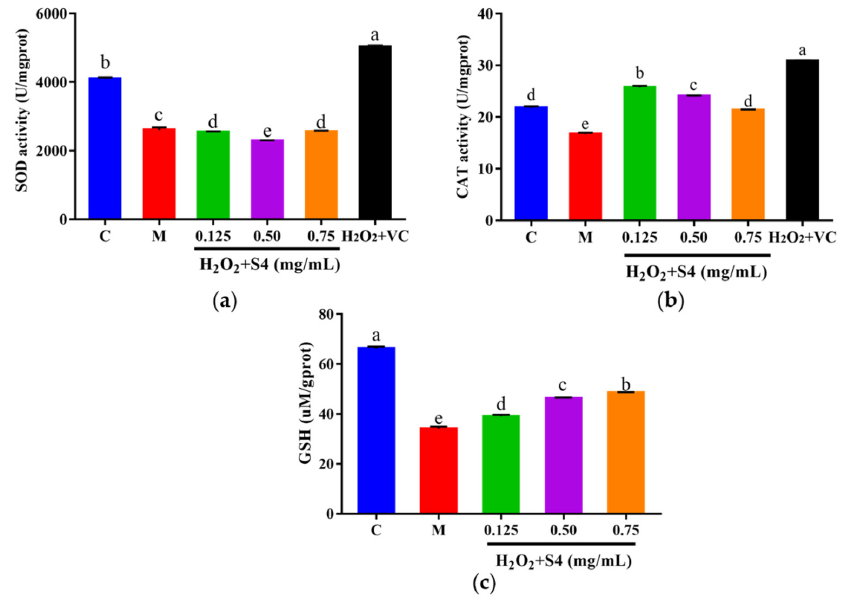
Figure 7. ( a ) SOD, ( b ) CAT activities, and ( c ) GSH level of HepG2 cells after S4 treatment. “C” rep- resents the control group, and “M” represents the model group. Data were expressed as mean ± SD ( n ≥ 3, p < 0.05). Different letters indicate significant differences ( p <